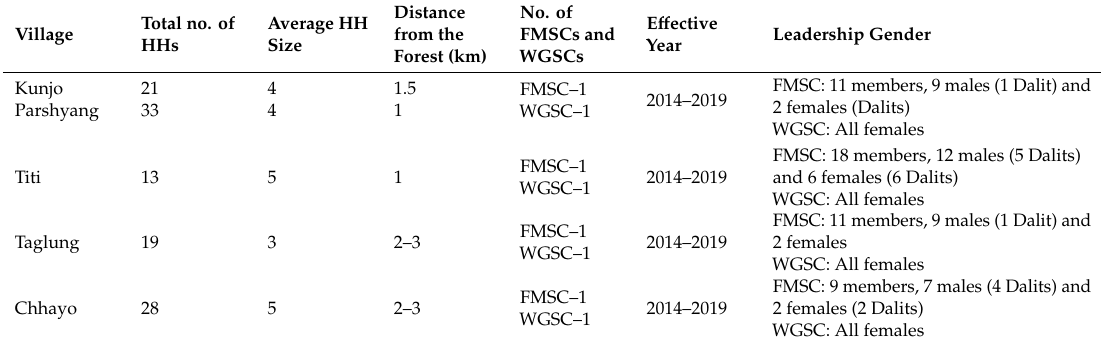
Table 2. Description of study